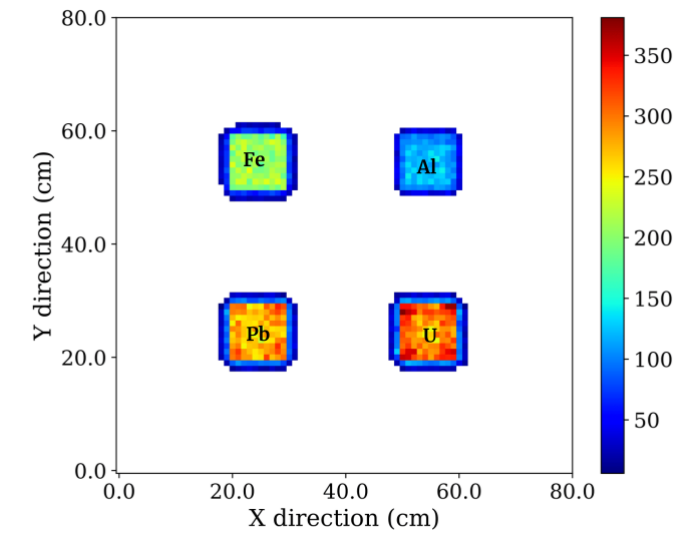
Figure 4. S-maps of scattering vertices after applying